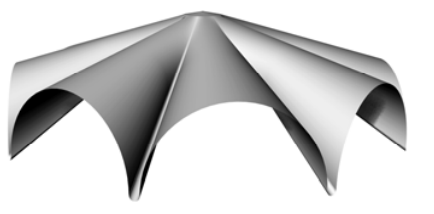
Figure 8. View of the ideal model.